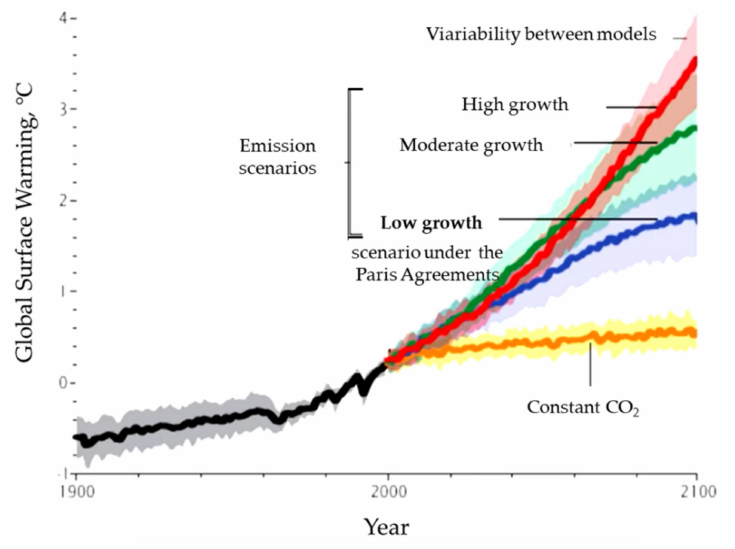
Figure 1. Temperature model with various scenarios related to human activity